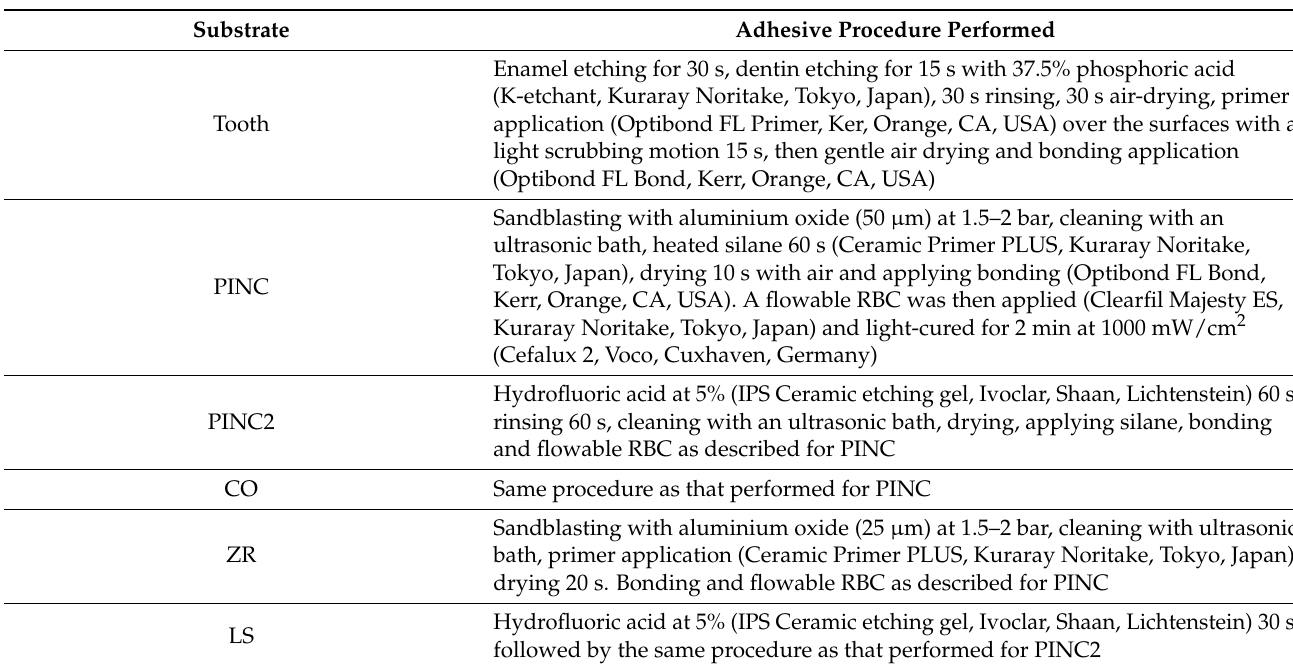
Table 2. Detailed adhesive procedures performed on the substrate and the various tested materials. Substrate Adhesive Procedure